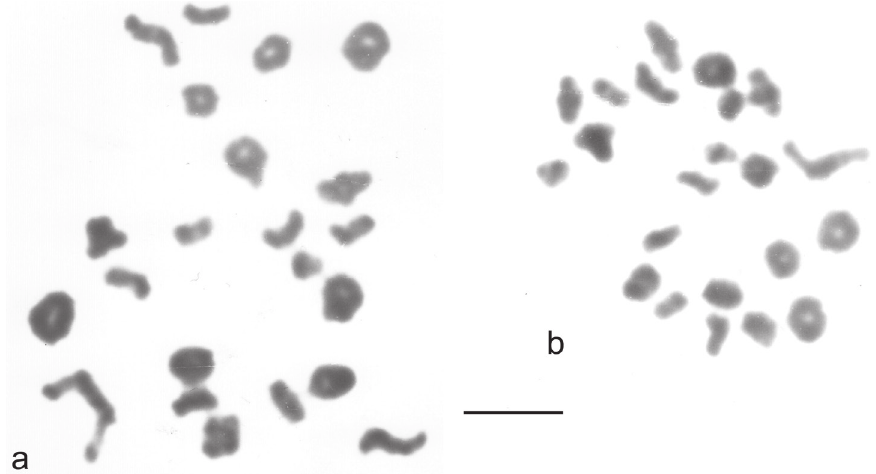
Figure 2. a , b A . infuscatus testis, first metaphase of meiosis. Bar = 5